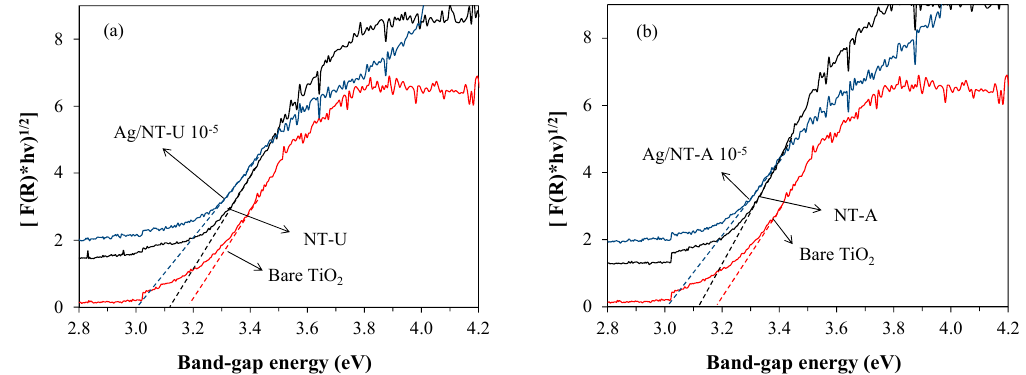
ff ect of Ag-doping on the band-gap energies of ( a ) NT-U and ( b ) NT-A Figure 8. Effect of Ag-doping on the band-gap energies of (a) NT-U and (b) NT-A catalysts. Figure 8. E